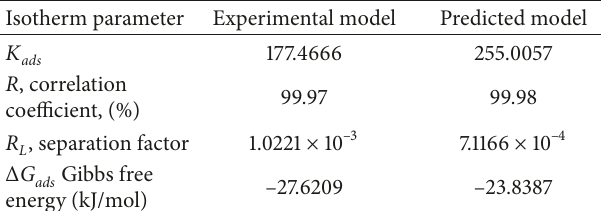
Table 3: Modelled Langmuir adsorption isotherm fitting parame-